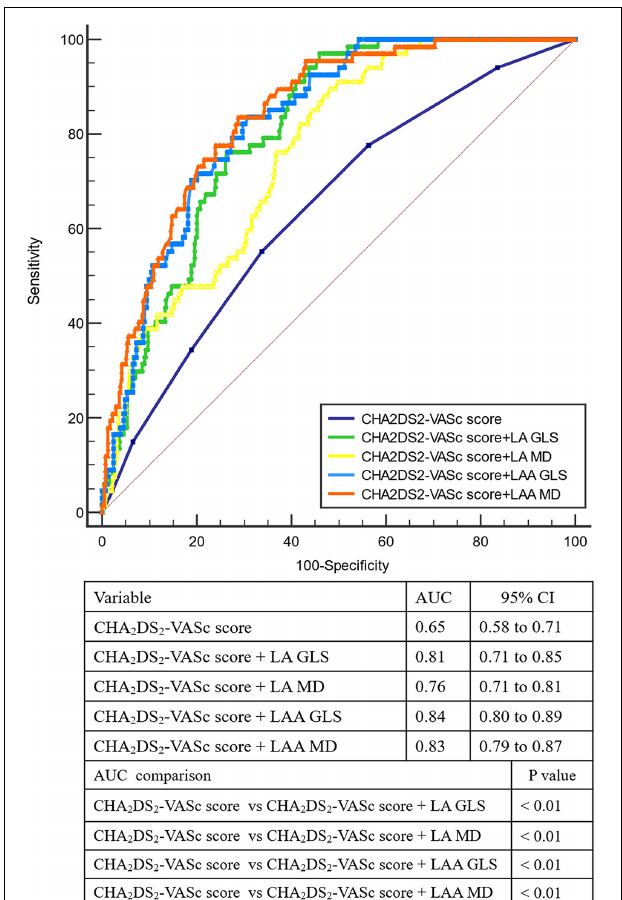
FIGURE 2 | Receiver-operating characteristic curve analysis for identifying LAA dense spontaneous echo contrast or thrombus. AUC, area under the curve; GLS, global longitudinal strain; LA, left atrium; LAA, left atrial appendage; MD, mechanical